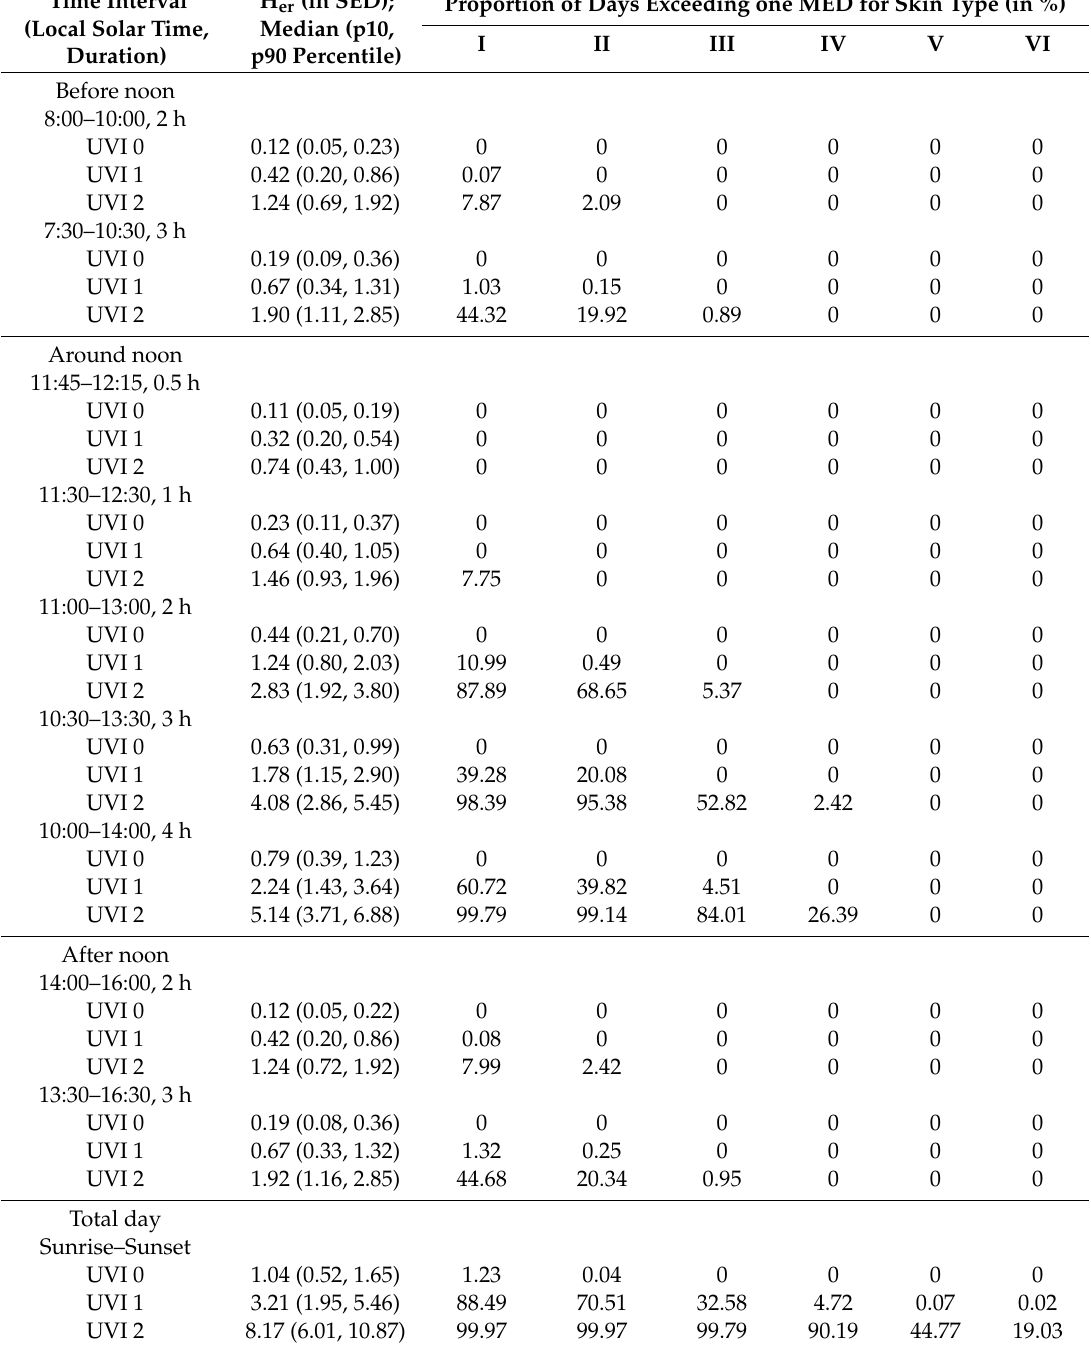
Table 4. Ambient erythemal UV doses (H er ) calculated for di ff erent time intervals on days with a UVI value of 0, 1, and 2 and corresponding proportion of days with doses from those intervals exceeding one MED for the Fitzpatrick [21] skin types I to VI. (1 SED = 1 standard erythema dose = 100 J / m 2 weighted with the CIE erythema reference action spectrum